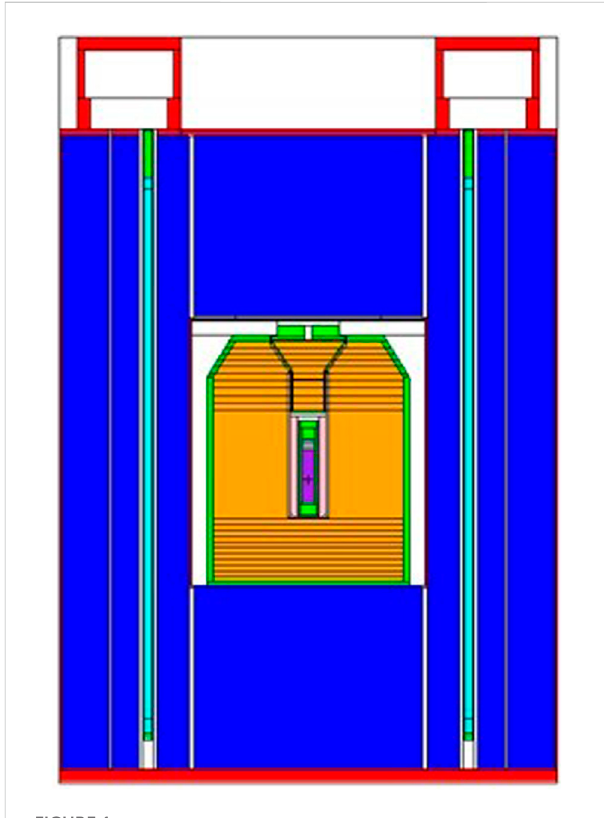
FIGURE 1 Schematic representation of the neutron detection system with the SNF segment sample in the transfer and transport containers. The fi gure is based on the MCNP input geometry using the version 5.1.60 (X-5 Monte Carlo Team, 2005). More details are given in Schillebeeckx et al.